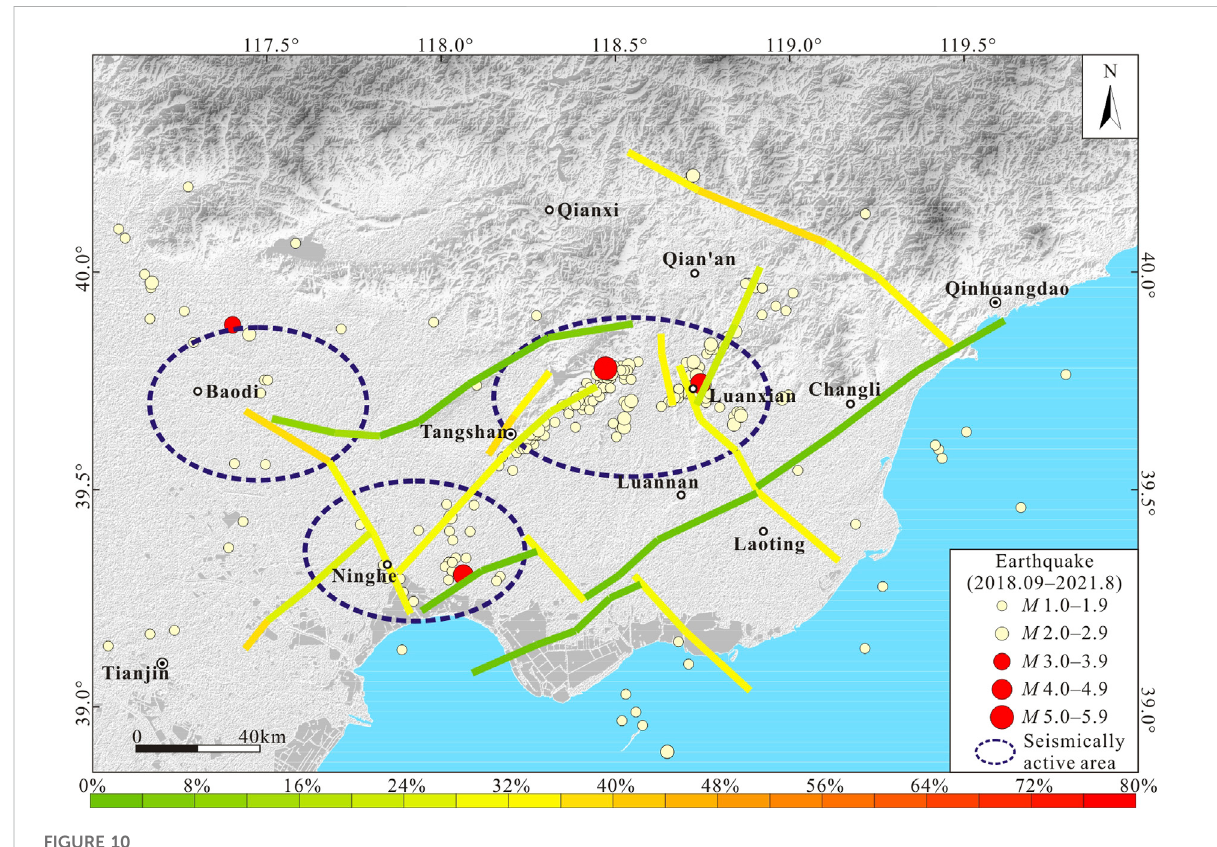
FIGURE 10 The fault slip potential on the main faults in Tangshan seismic region in stage